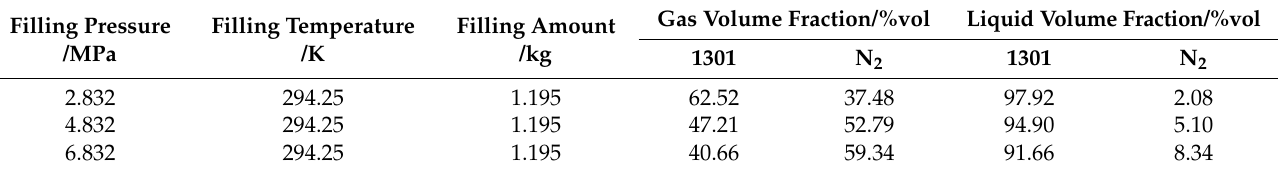
Table 1. Initial state of the extinguishing bottle under different filling pressures.